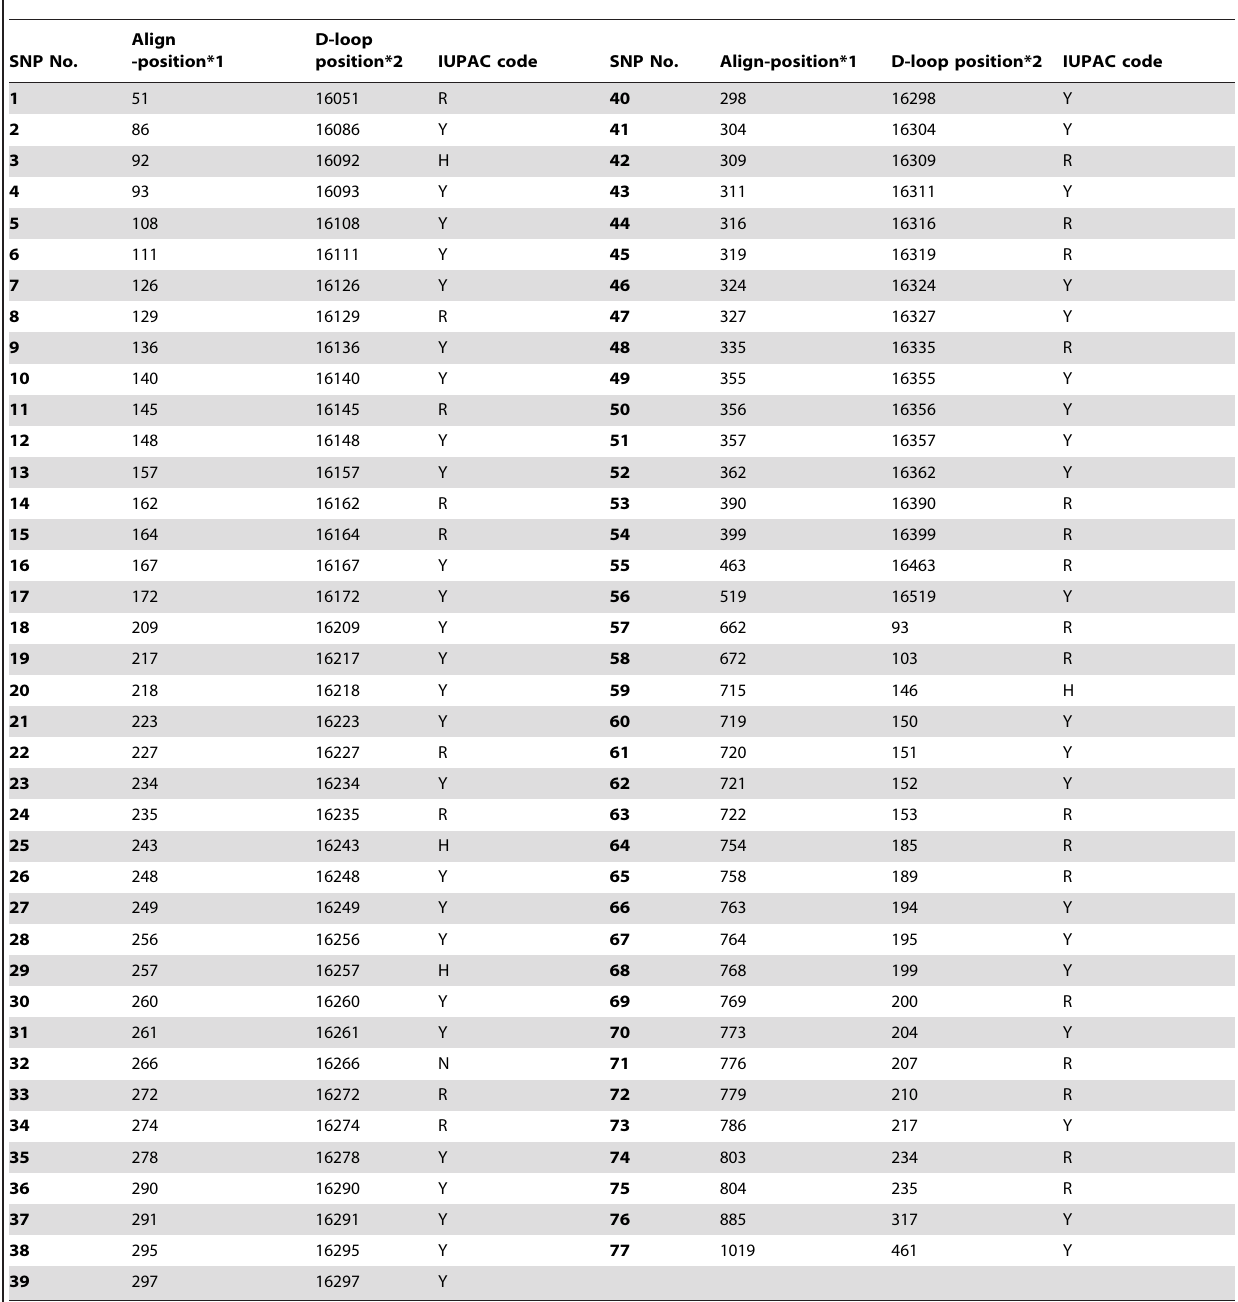
Table 2. SNP identification from aligned sequences of cases and controls and their positional information.